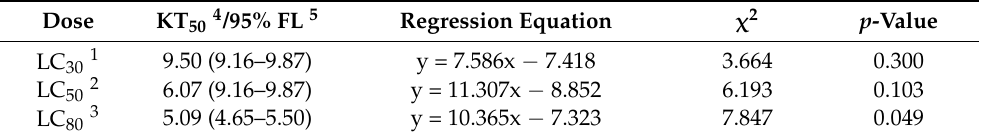
Table 2. 50% knockdown times caused by (-)-4-terpineol dissolved in acetone and applied as fumi- gants on P. xylostella